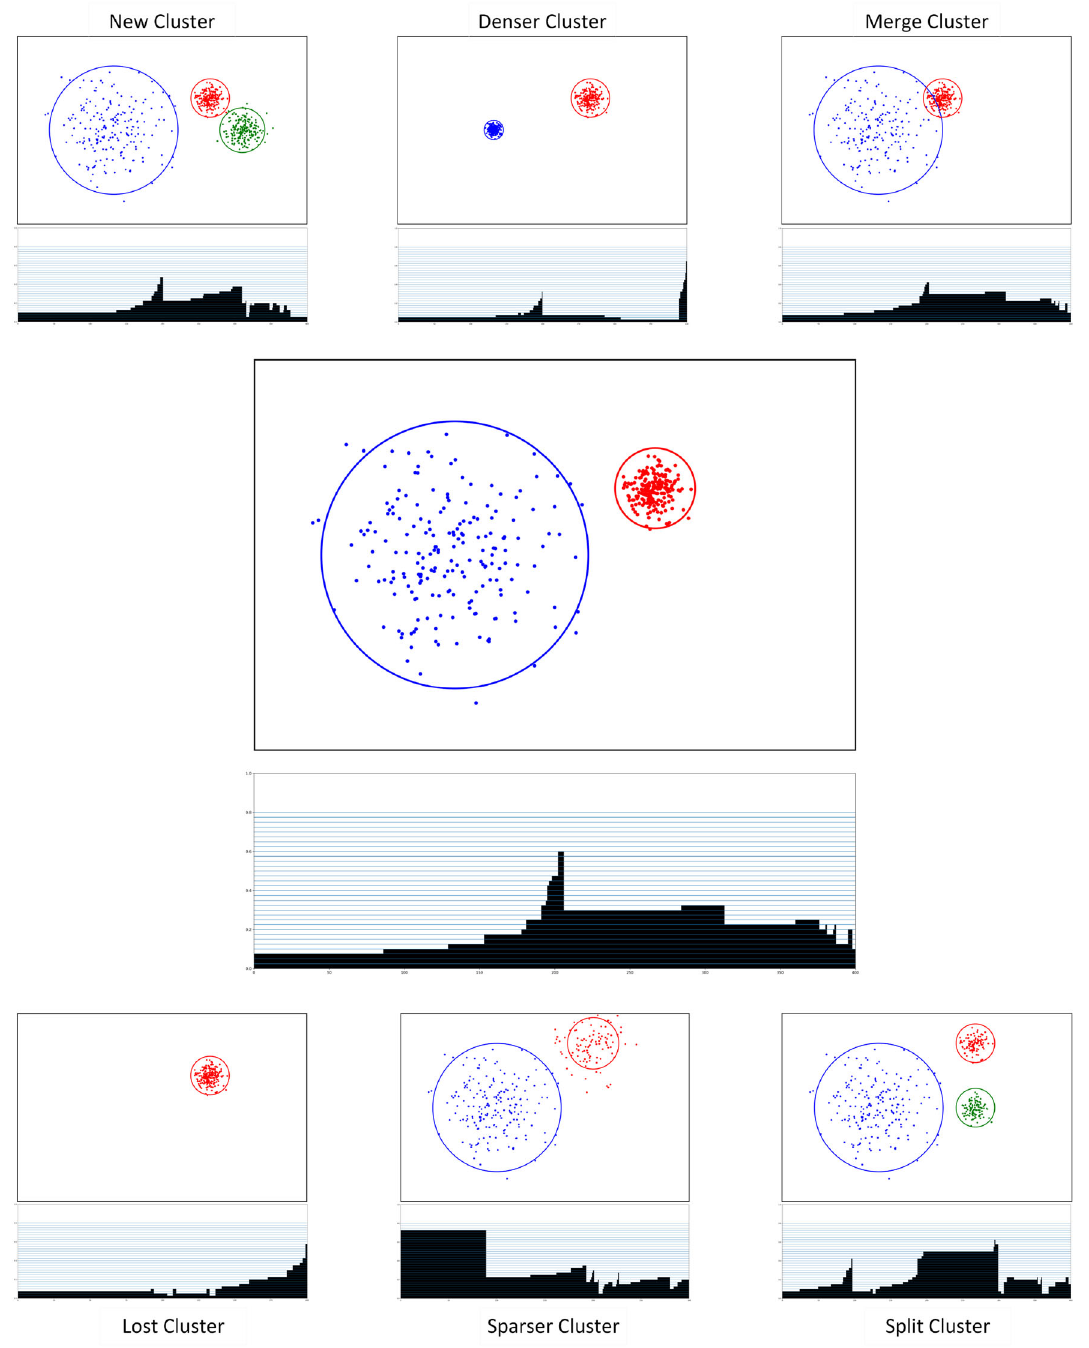
Fig. 6 Influence and observation patterns on AMTICS due to differ- ent types of concept drifts. The middle area shows the original pattern before the drift. From top-left to bottom-right, we observe (1) creation